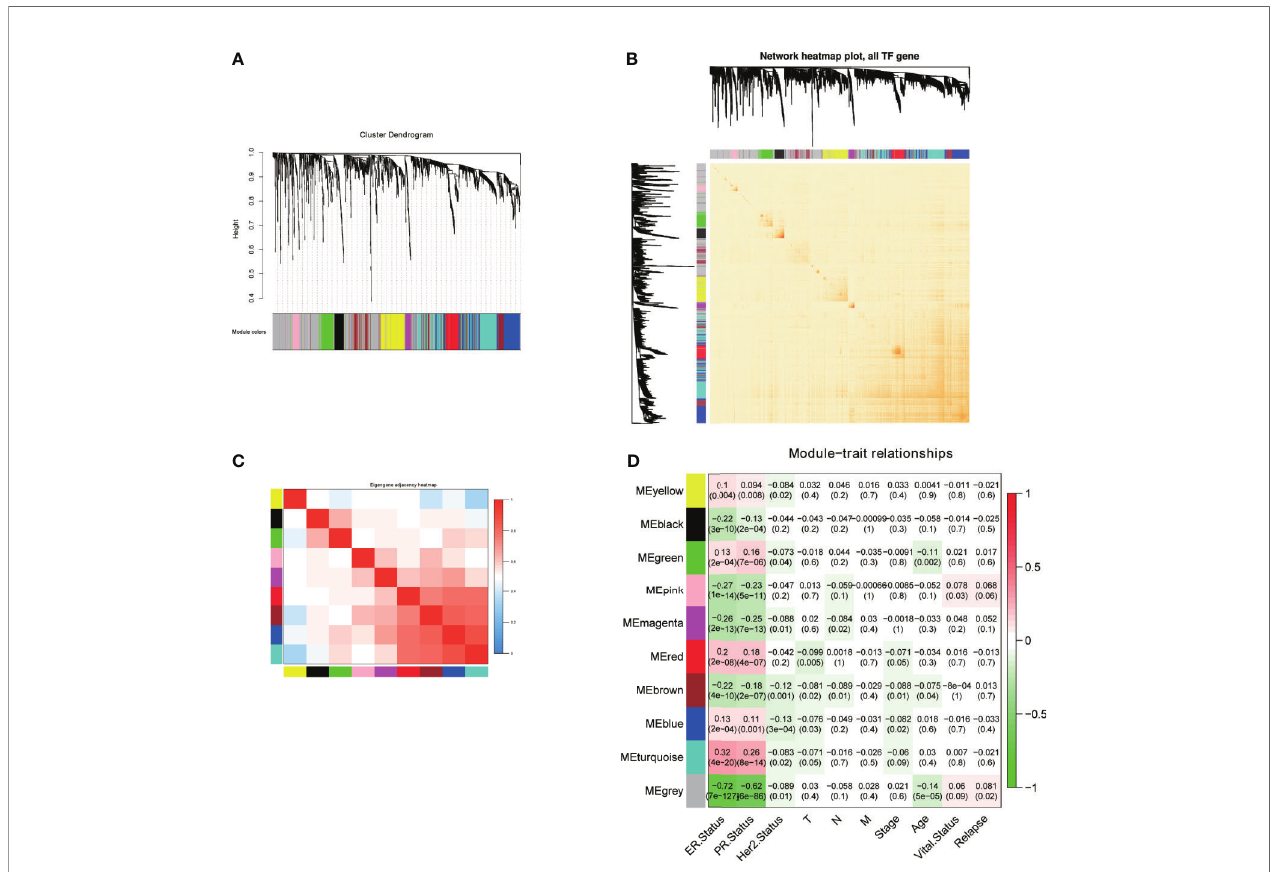
FIGURE 1 | Construction of the WGCNA for TFs. (A) Dendrogram of the genes modules based on a dissimilarity. (B, C) Heatmap of correlation coef fi cient expressed between modules. (D) Relationships between consensus module eigengenes and various clinical